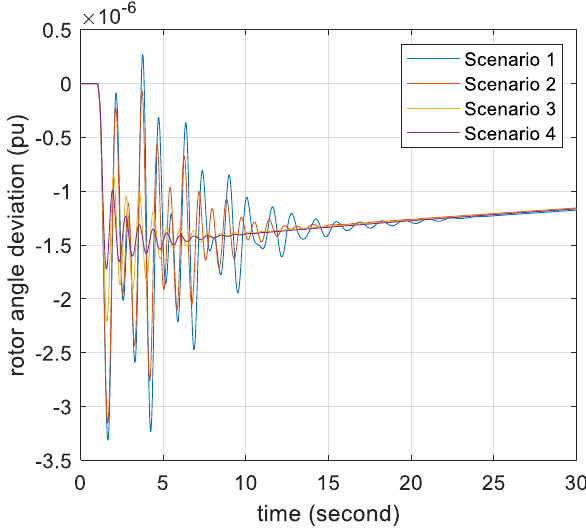
Figure 8. Rotor speed responses of G4.